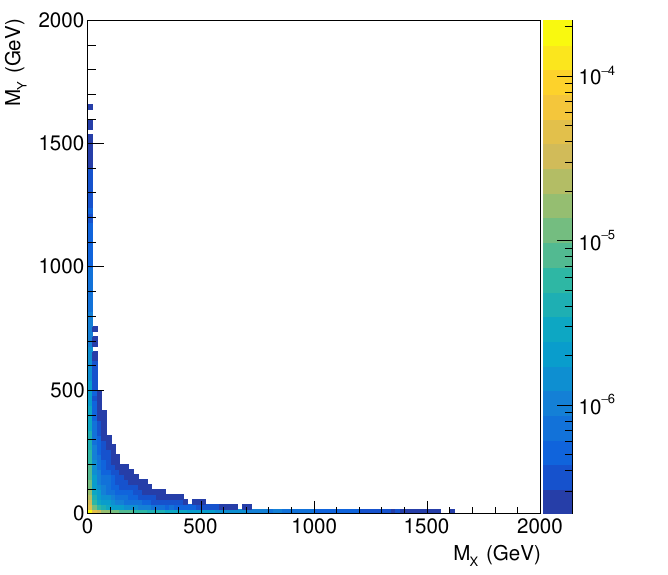
Figure 8 . The two-dimensional d 2 (cid:27) distribution as a function of M X (cid:2) M Y in nb/GeV 2 for dM X dM Y the inelastic-inelastic contribution.